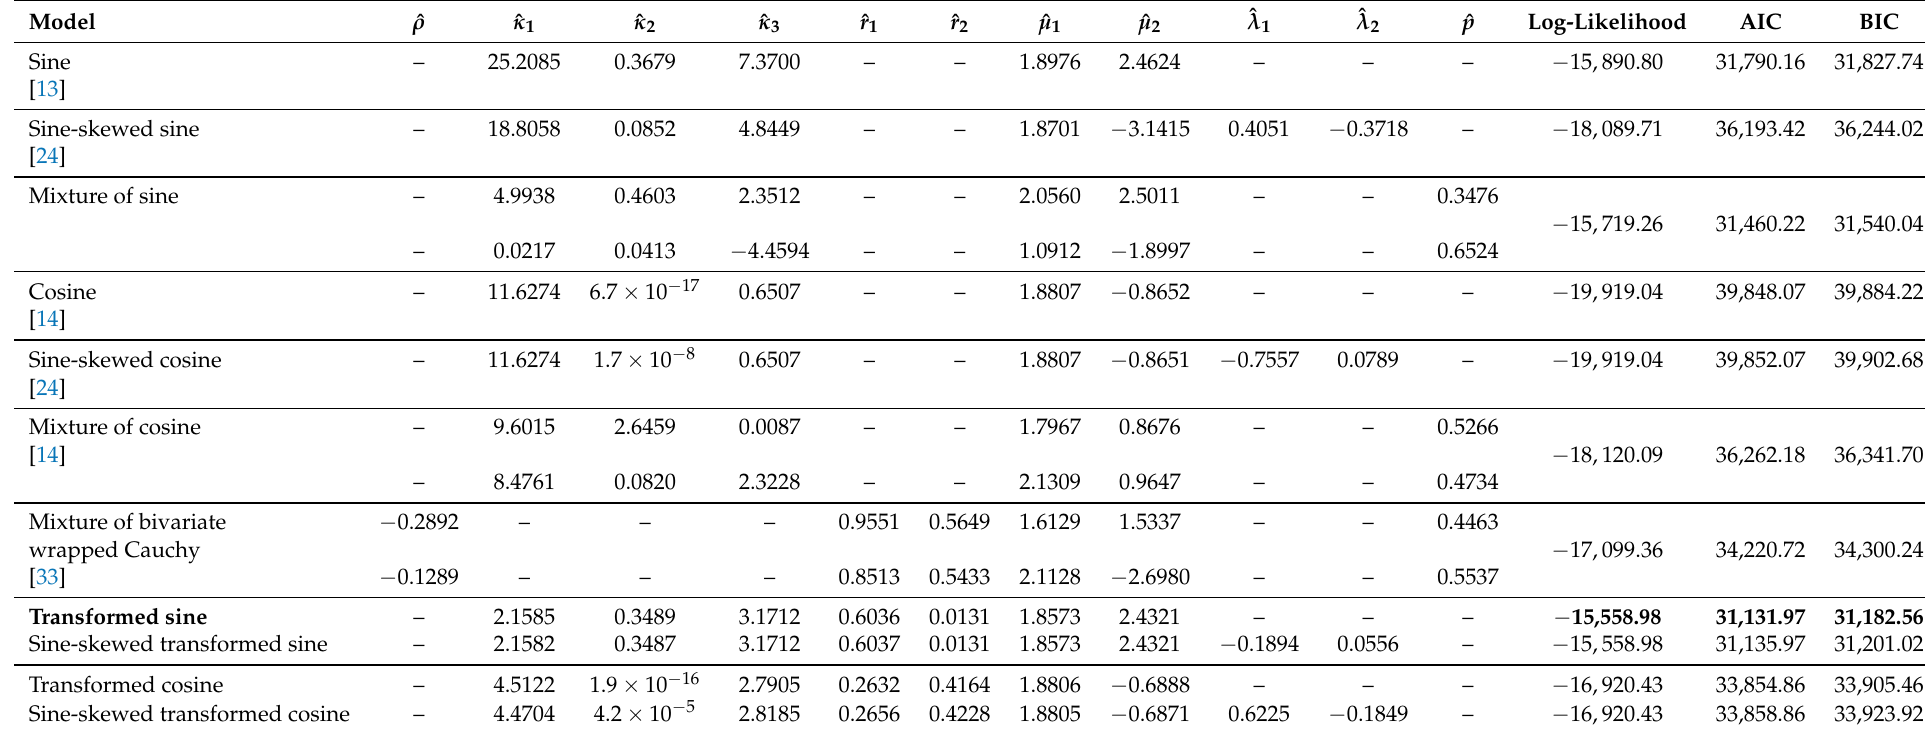
Table 1. Maximum likelihood estimates and corresponding log-likelihood, AIC, and BIC for SCOP.1 ( n =